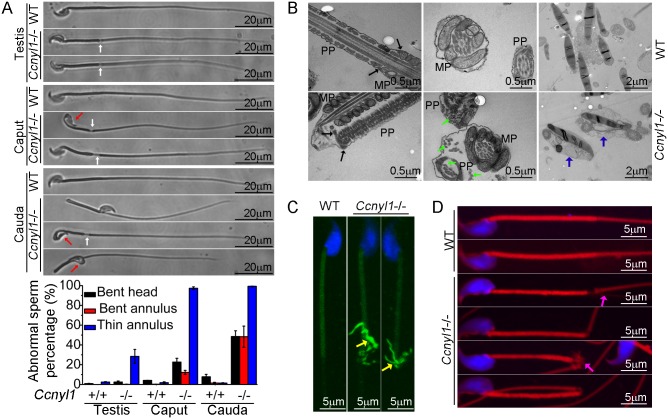
Morphological defects of Ccnyl1-/- spermatozoa.(A) Phase Contrast images of spermatozoa collected from the testis, caput and cauda epididymidis of adult WT and Ccnyl1-/- mice. Ccnyl1-/- spermatozoa showed a thinning of annulus (white arrows) and a bent head wrapped around the neck (red arrows). Scale bar: 20μm. The ratios of defects are summarized in the histograms below (mice: n≥ 3 animals per group). Data are presented as mean ± SEM. (B) TEM images of spermatozoa collected from the cauda epididymidis of adult WT and Ccnyl1-/- mice. MP: Middle Piece; PP: Principal Piece. The annulus structure (black arrows) closely linked the MP and PP in WT spermatozoa, but was distant from the MP as the thinning of the annulus region in Ccnyl1-/- spermatozoa. Microtubules (green arrows) were dispersed out of the PP in Ccnyl1-/- spermatozoa. Two Ccnyl1-/- spermatozoa with bent heads wrapped by cytoplasmic contents are shown (blue arrows). Scale bar for the top and middle panels: 0.5 μm, scale bar for the bottom panels: 1 μm. (C and D) Immuno-labeling of α-tubulin (C) and F-actin (D) of spermatozoa collected from cauda epididymidis of adult WT and Ccnyl1-/- mice. Microtubules (yellow arrows) and F-actin (pink arrows) were extruded from of this region in spermatozoa of Ccnyl1-/- mice, scale bar: 5 μm.